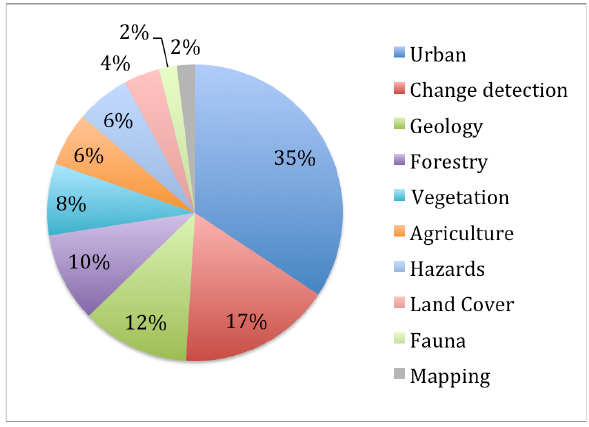
Figure 5a. Applications as published in indexed journal papers